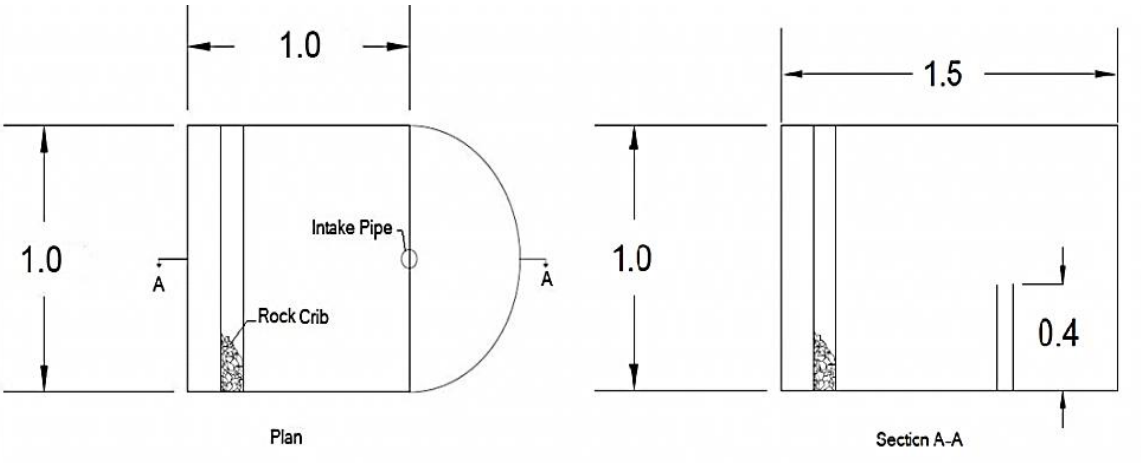
Fig. 2 Schematic diagram of the tank used in the present